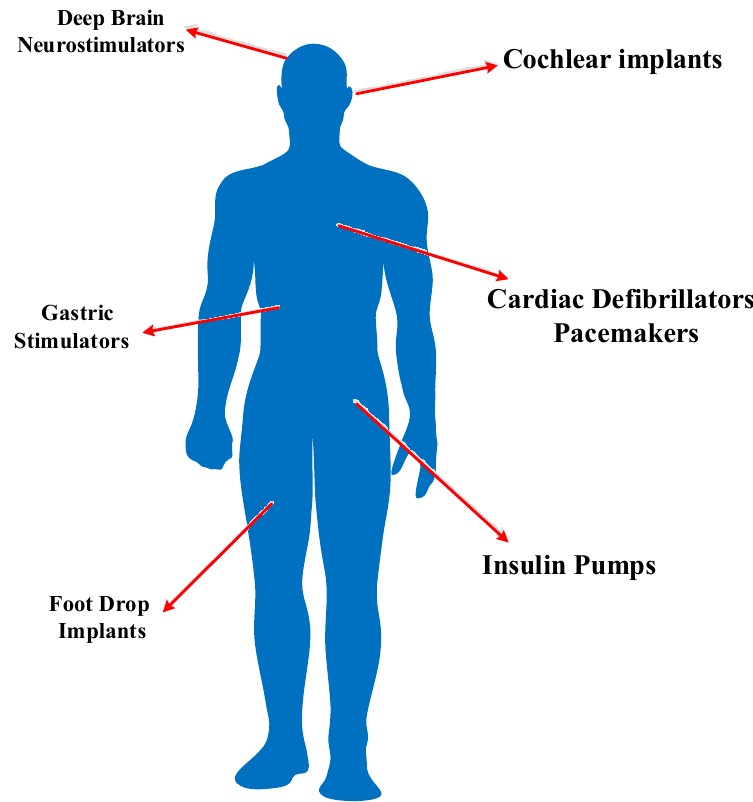
Figure 1. Implantable medical devices for various applications.